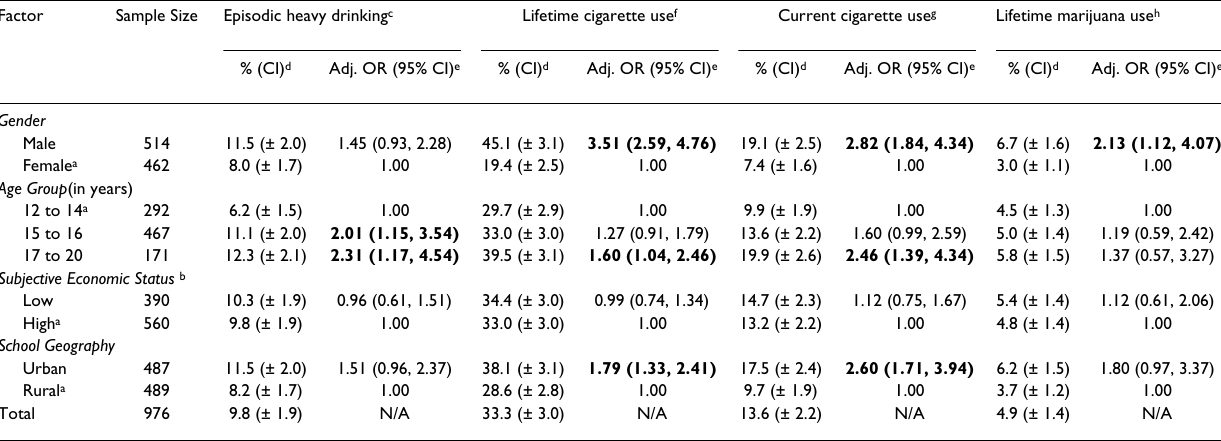
Table 4: Prevalence of selected substance abuse behaviors among eighth and ninth grade secondary students attending public schools in a central region of El Salvador by socio-demographic characteristics, 1999 Factor Sample